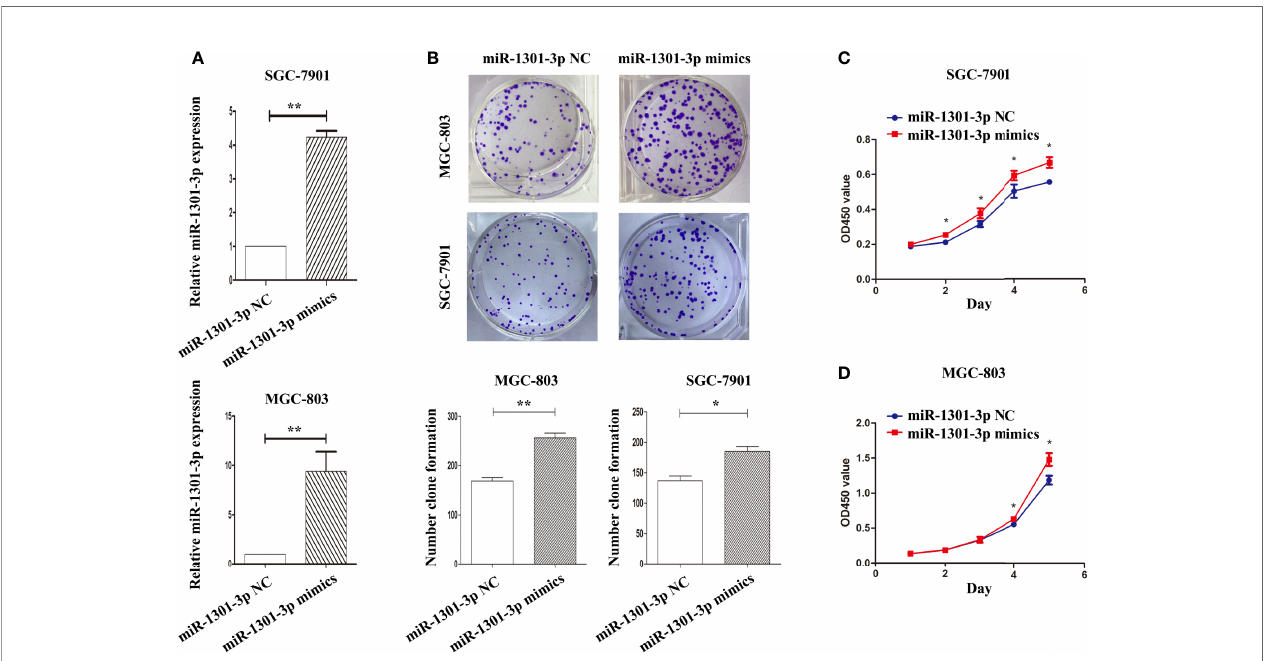
FIGURE 2 | Overexpression of miR-1301-3 promotes the proliferation of GC cells. (A) qRT-PCR was utilized to verify the ef fi cacy of transfection. (B) Colony formation assay demonstrated overexpression of miR-1301-3p enhanced the proliferation of GC cells. (C, D) CCK-8 assay demonstrated that overexpression of miR-1301-3p promoted the proliferation of GC cells. *p < 0.05, **p < 0.01.